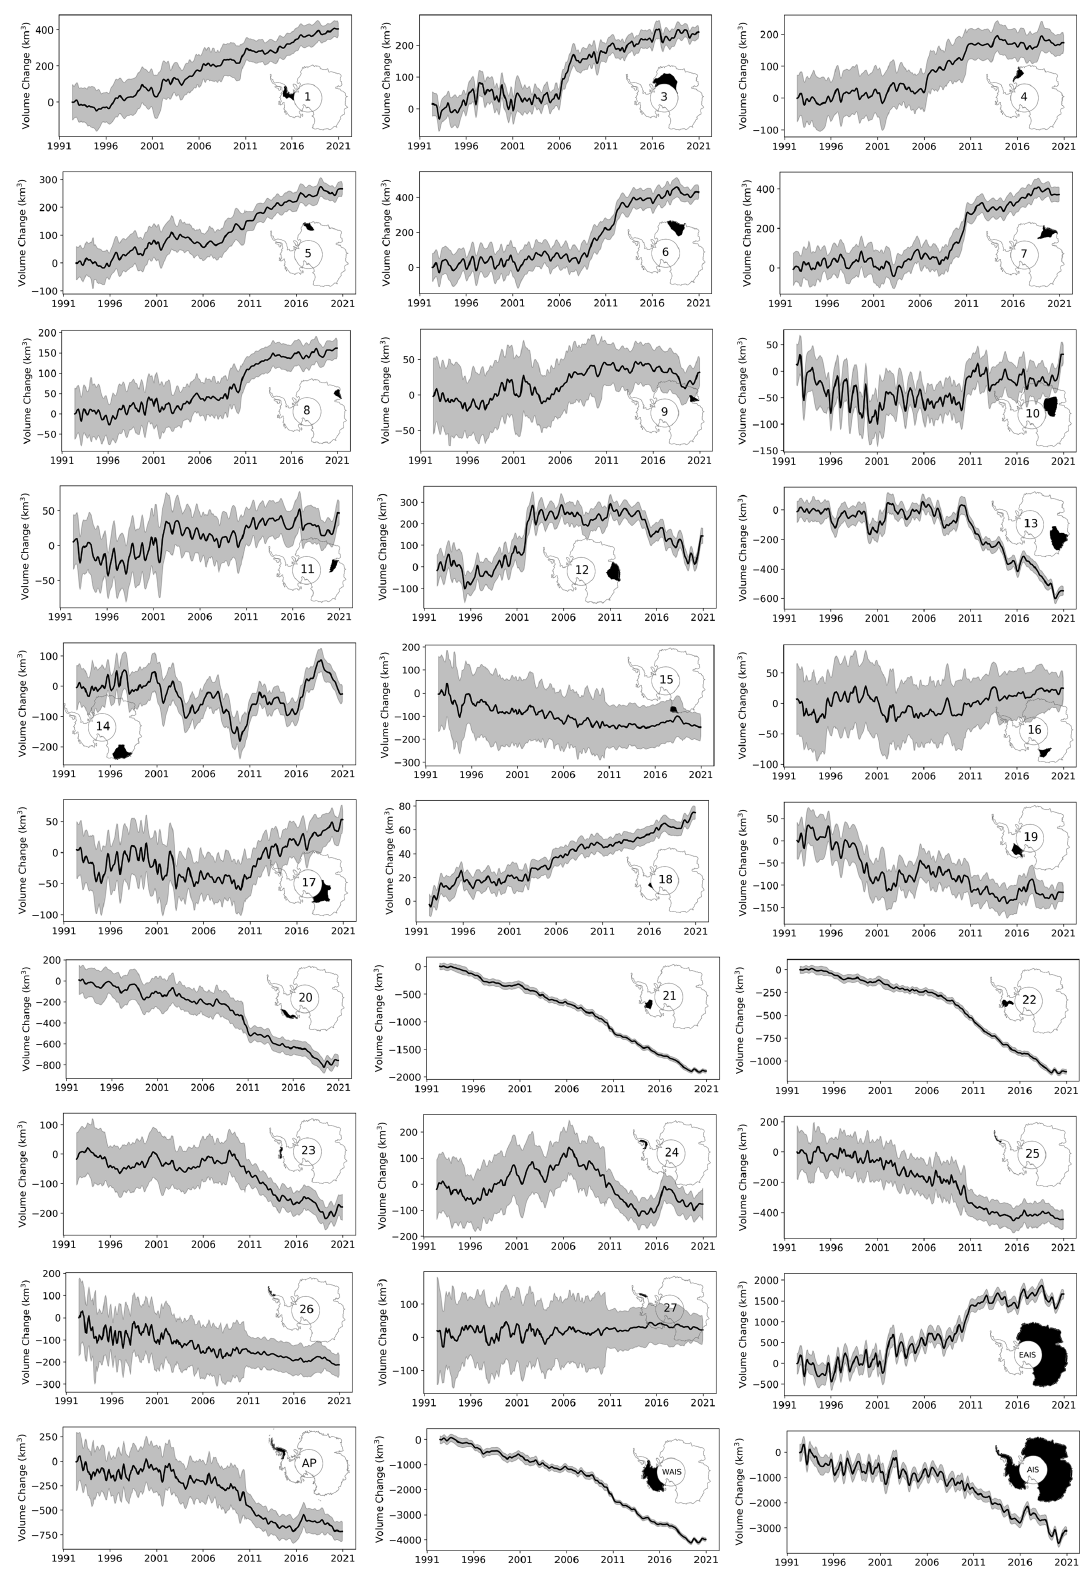
Figure 11. Basin (Zwally et al., 2012) and ice sheet monthly elevation change time series for the period of 1992 to 2020.